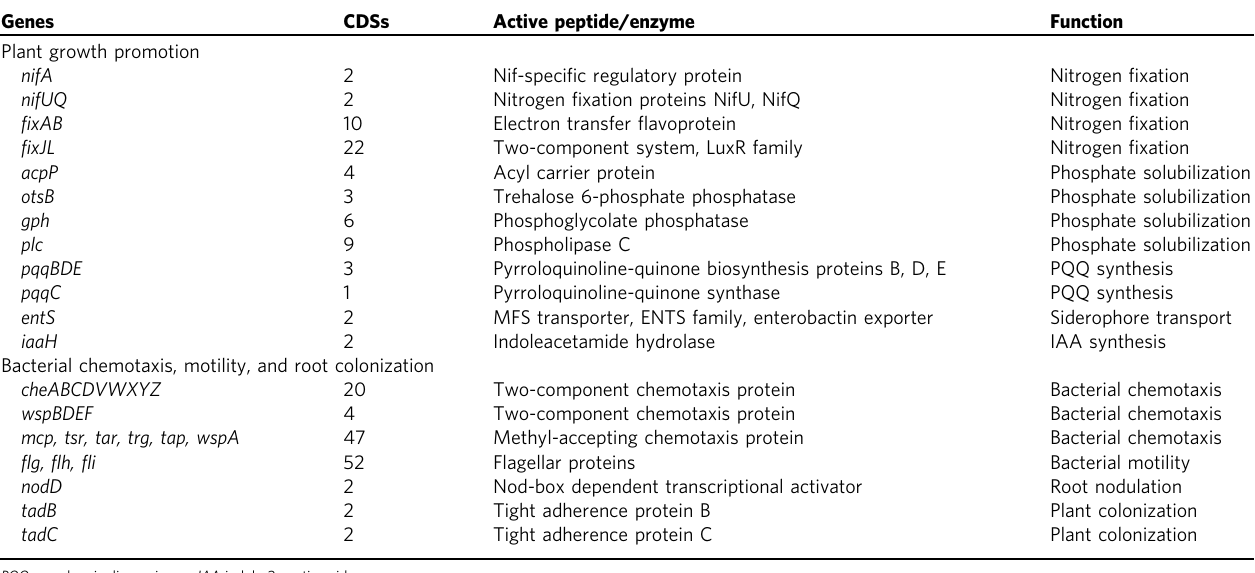
Table 1 Key genes in Paraburkholderia tropica WTPI1 genome that are putatively involved in plant growth promotion, bacterial chemotaxis, motility, root modulation, and colonization (See Supplementary Table 2 for more details).